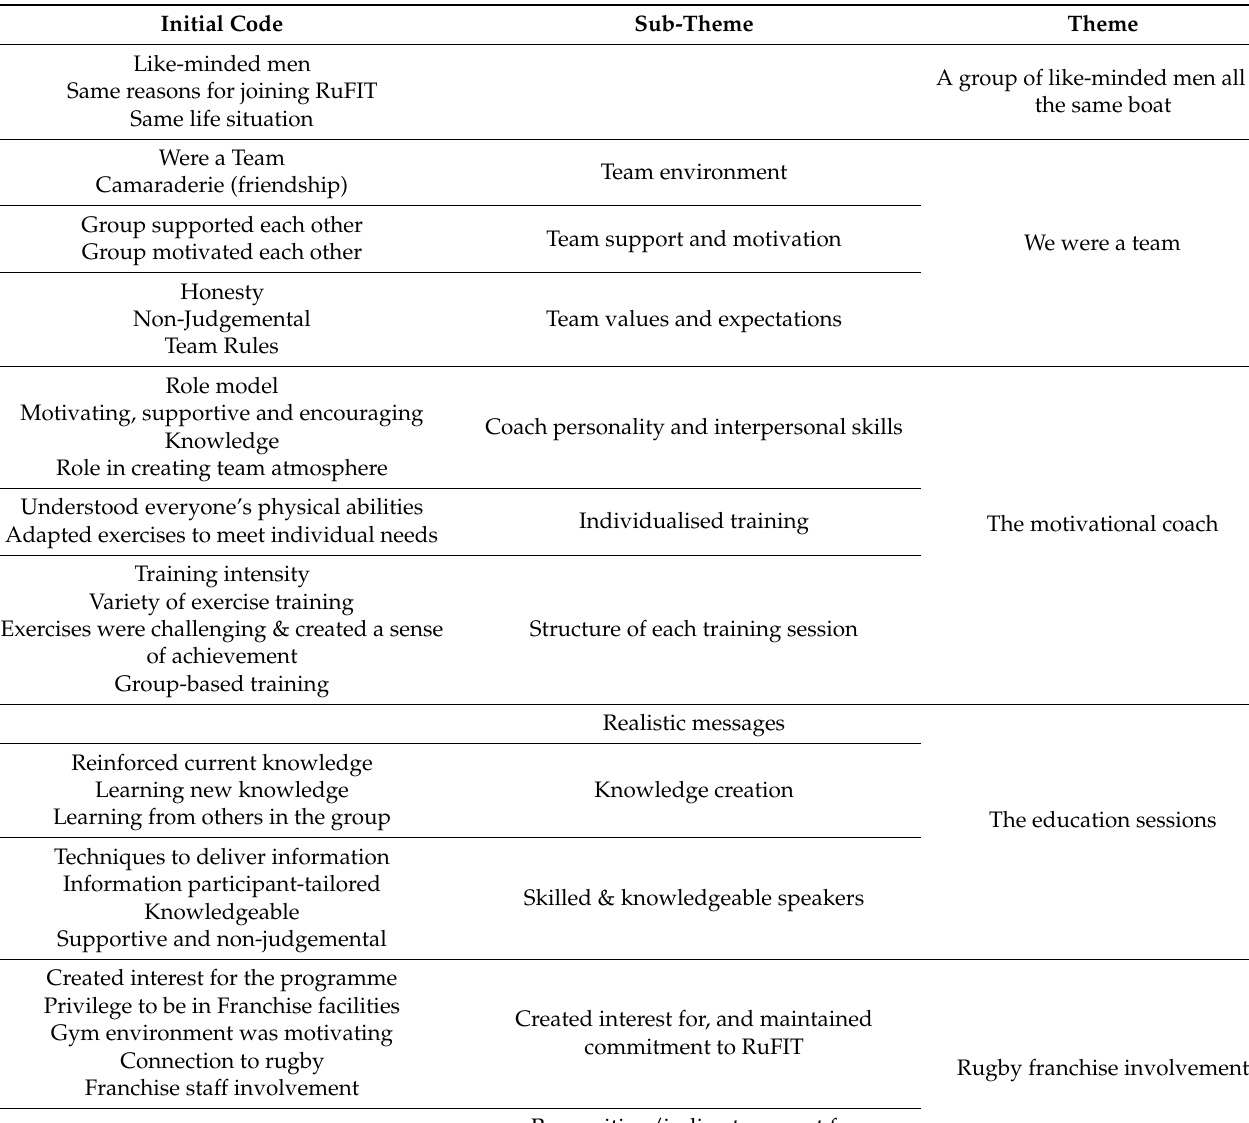
Table 1. Thematic analysis of factors explaining engagement with the Rugby Fans in Training—New Zealand programme (RuFIT-NZ) pilot